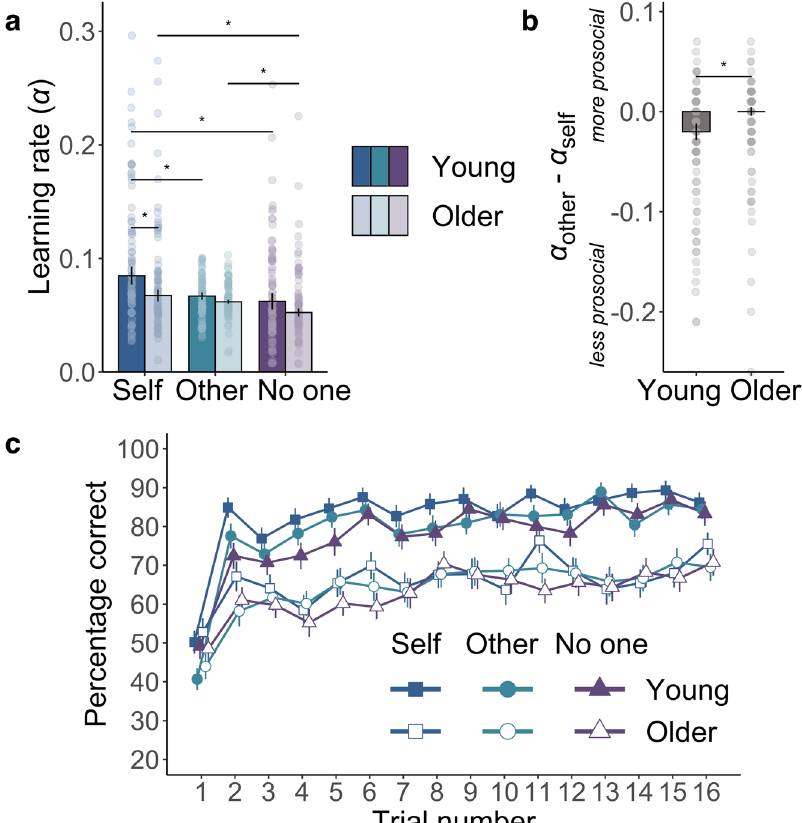
Fig. 3 Age-group differences in accuracy and learning rates. a Comparison of learning rates ( α ) from the computational model shows older adult ’ s prosocial learning was preserved. Learning rates were calculated in the self (blue), other (green) and no one (purple) conditions, and are plotted separately for the young (strong colours) and older (pastel colours) age groups. Older adults ’ learning rates in the other condition did not differ from the self condition ( V = 1150, Z = − 1.45, r (75) = 0.17 [0.01, 0.38], P = 0.15, BF 01 = 1.08) or from young adults ’ prosocial learning rates ( W = 3042, Z = − 0.86, r (150) = 0.07 [0.003, 0.24], P = 0.39, BF 01 = 4.26). In contrast, young participants learned faster for themselves than another person ( V = 659, Z = − 4.04, r (75) = 0.47 [0.26, 0.63], P < 0.001), n = 150 (75 young, 75 older). Bars show group median, error bars are standard error of the median, asterisks represent signi fi cant two-sided between-group and within-group Wilcoxon t tests ( P < 0.05). b Median difference between α other and α self illustrates the signi fi cant age group * recipient [self vs. other] interaction ( b = 0.02 [0.002, 0.03], Z = 2.29, P = 0.02), n = 150 (75 young, 75 older). Error bars are standard error of the median, the asterisk represents the signi fi cant interaction from the robust linear mixed-effects model. c Group-level learning curves showing choice behaviour in the three recipient conditions (self: blue squares, other: green circles, no one: purple triangles) for each age group (young: fi lled, older: empty shapes). Trials are averaged over the three blocks (48 trials total per recipient presented in three blocks of 16 trials) for the self, other and no one recipients, n = 152 (75 young, 77 older). Points show group mean, error bars are standard error of the mean. Source data are provided as a Source Data fi